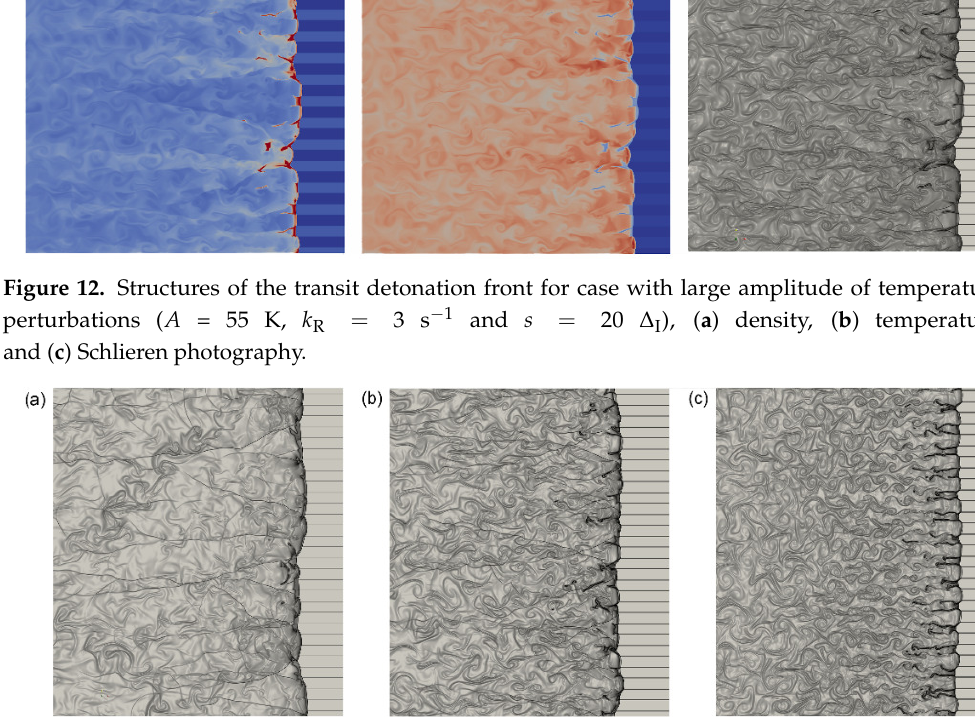
Figure 13. Schlieren photography of detonation front under artificial perturbations with different amplitude with s = 20 ∆ I and k R = 4 s − 1 , ( a ) A = 15 K, ( b ) A = 45 K, and ( c ) A = 105